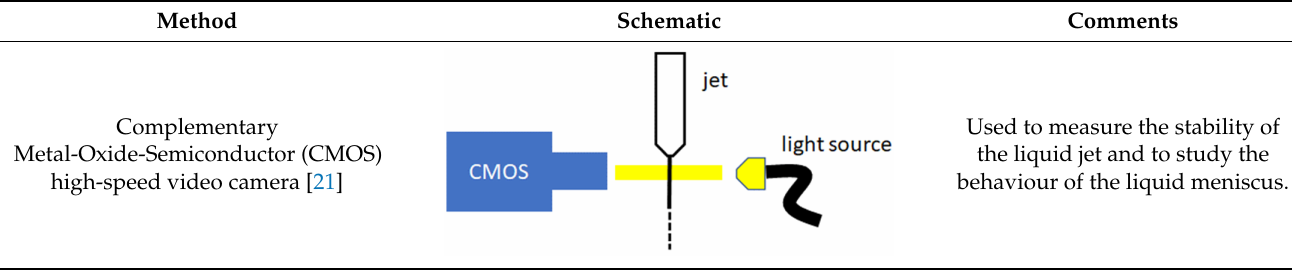
Figure 11. Experimental images of a hydrodynamic focusing mixer evaluated with the fluorescein- iodide quenching reaction technique for three sheath flow rates ( Q sh ) to sample flow rate ( Q sa ) ratios ( Q sh / Q sa ), ( a ) flow rate ratio of 100, ( b ) flow rate ratio of 1000, ( c ) flow rate ratio of 5000. At lower sheath to sample flow rate ratios, the sheath species diffuse into the sample stream (reprinted with permission from Reference [58]). Table 2. Summary of the techniques used to characterise liquid jetting (see Section